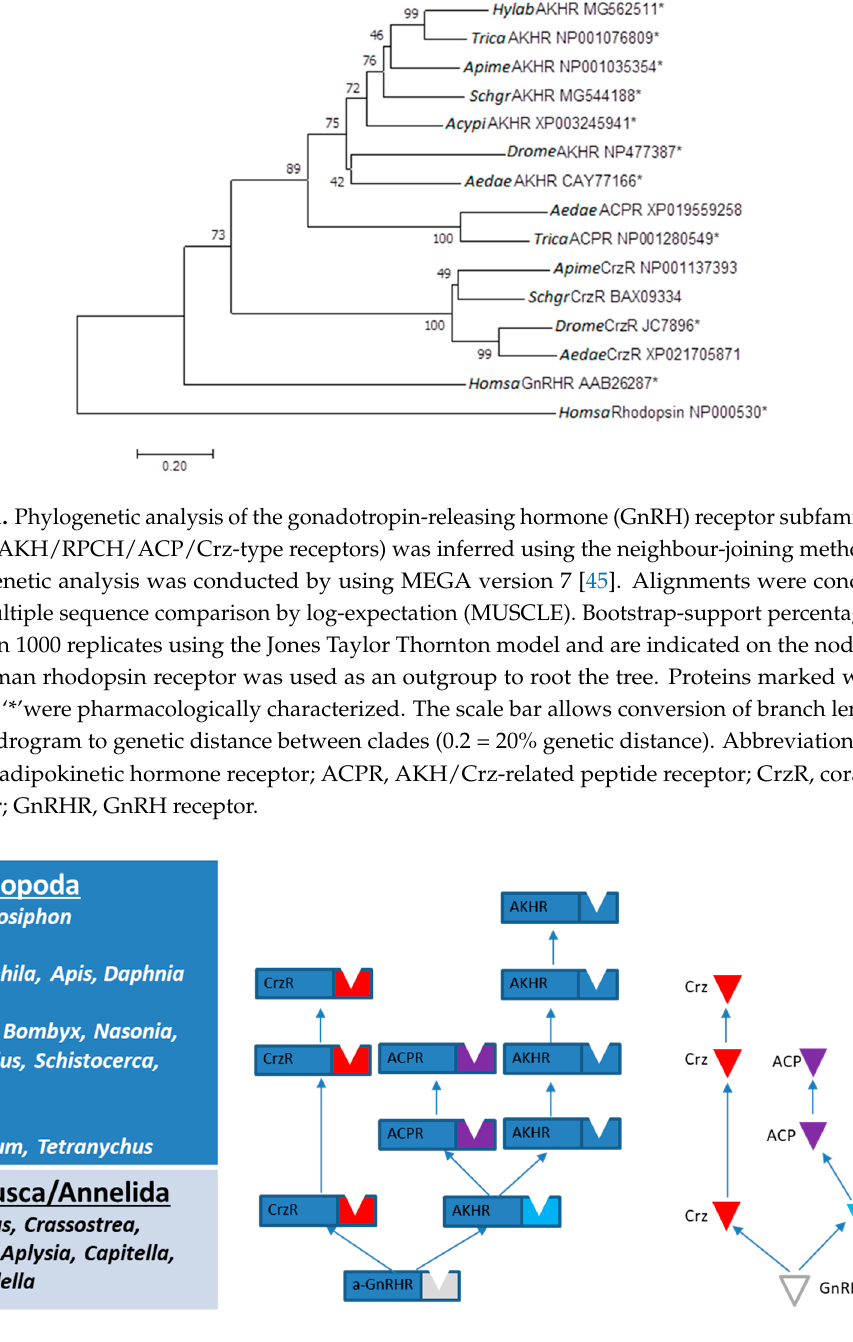
Figure 2. Presence of the AKH/ACP/Crz signaling systems in different arthropod species, based on present study and literature data [11,35,49].